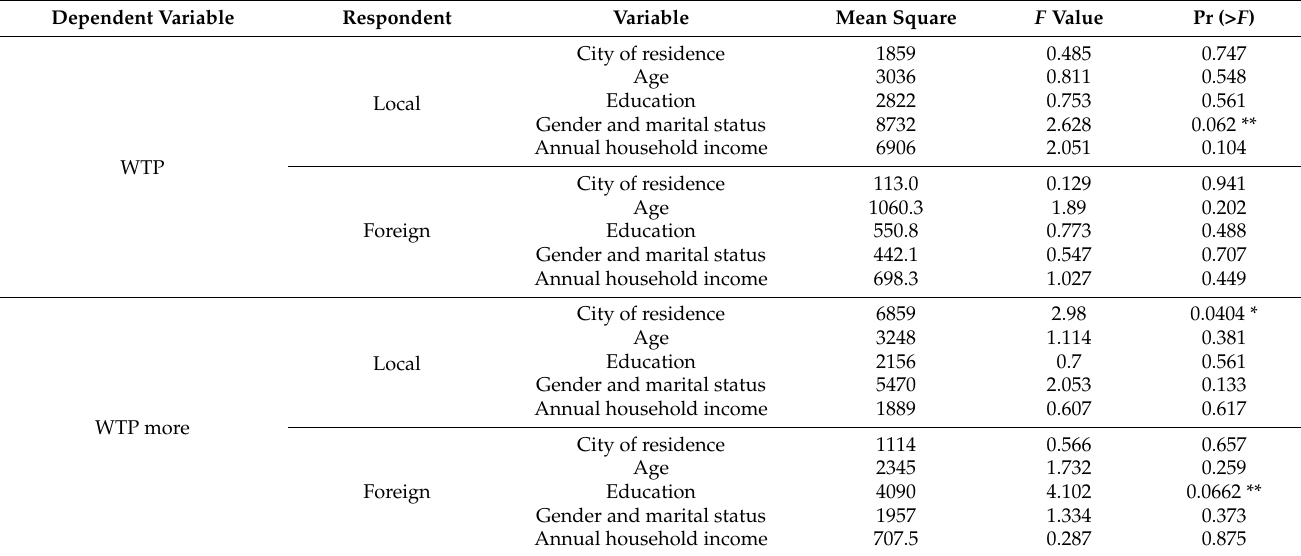
Table 7. One-way ANOVA tests for treatment respondents’ characteristics on